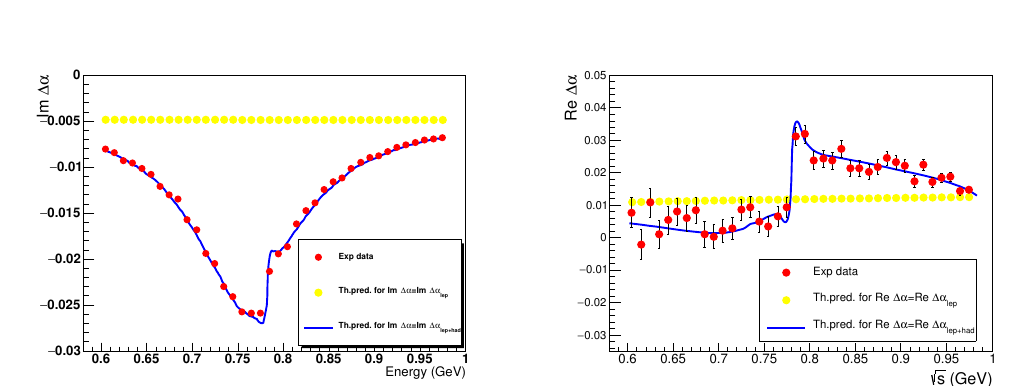
Figure 3. Left: Im ∆ α extracted from the KLOE data compared with the values provided by alphaQED routine (without the KLOE data) for Im ∆ α = Im ∆ α lep (yellow points) and Im ∆ α = Im ∆ α lep + had only for ππ channels (blue solid line). Right: Re ∆ α extracted from the experimental data with only the statistical error included compared with the alphaQED prediction (without the KLOE data) when Re ∆ α = Re ∆ α lep (yellow points) and Re ∆ α = Re ∆ α lep + had (blue solid